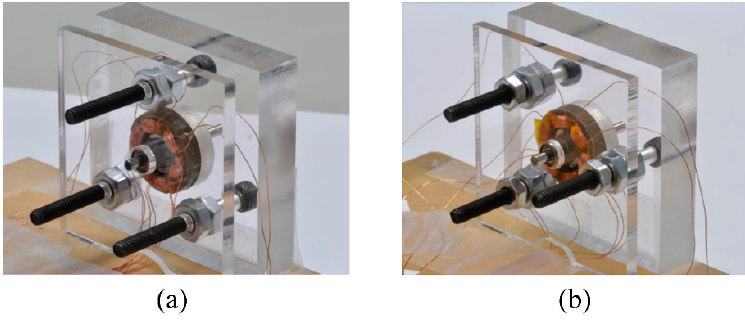
Figure 11. Assembled motors made of ( a ) 35CS300 and ( b ) Somaloy 700 1P.